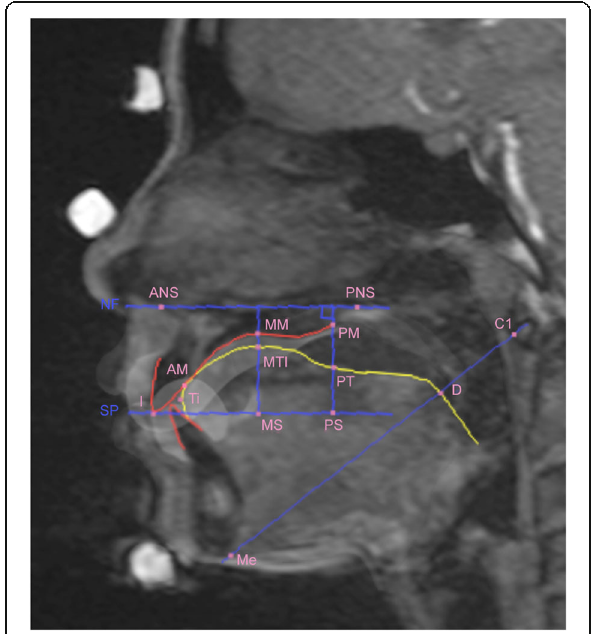
Fig. 5 Lines and points on the cine-magnetic resonance image after superimposition of the static image. Red line: tracing of the upper incisor, hard palate, and lower incisor. Yellow line: tracing of the tongue. Blue line: the planes used in the analysis. Pink dots: the points used in the analysis. Please refer to Table 1 for abbreviations